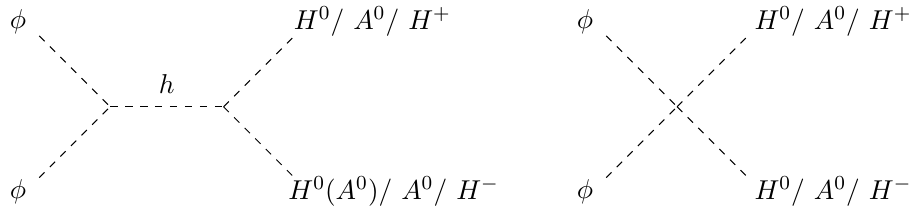
Figure 7 . Co-annihilation processes of IDM ( H 0 ) with A 0 and H (cid:6) to SM particles. SM in the top left graph stands for W (cid:6) ; Z; h and SM fermions in suitable combination.